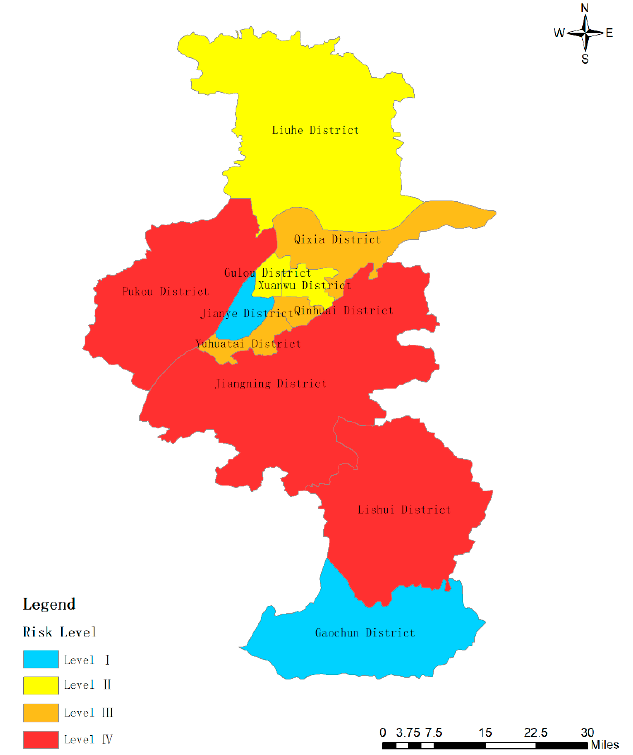
Figure 5. Risk level of subsystem Y 23 in Nanjing. Int. J. Environ. Res. Public Health 2020 , 17 , x Figure 5. Risk level of subsystem 𝑌 (cid:2870)(cid:2871) in Nanjing.